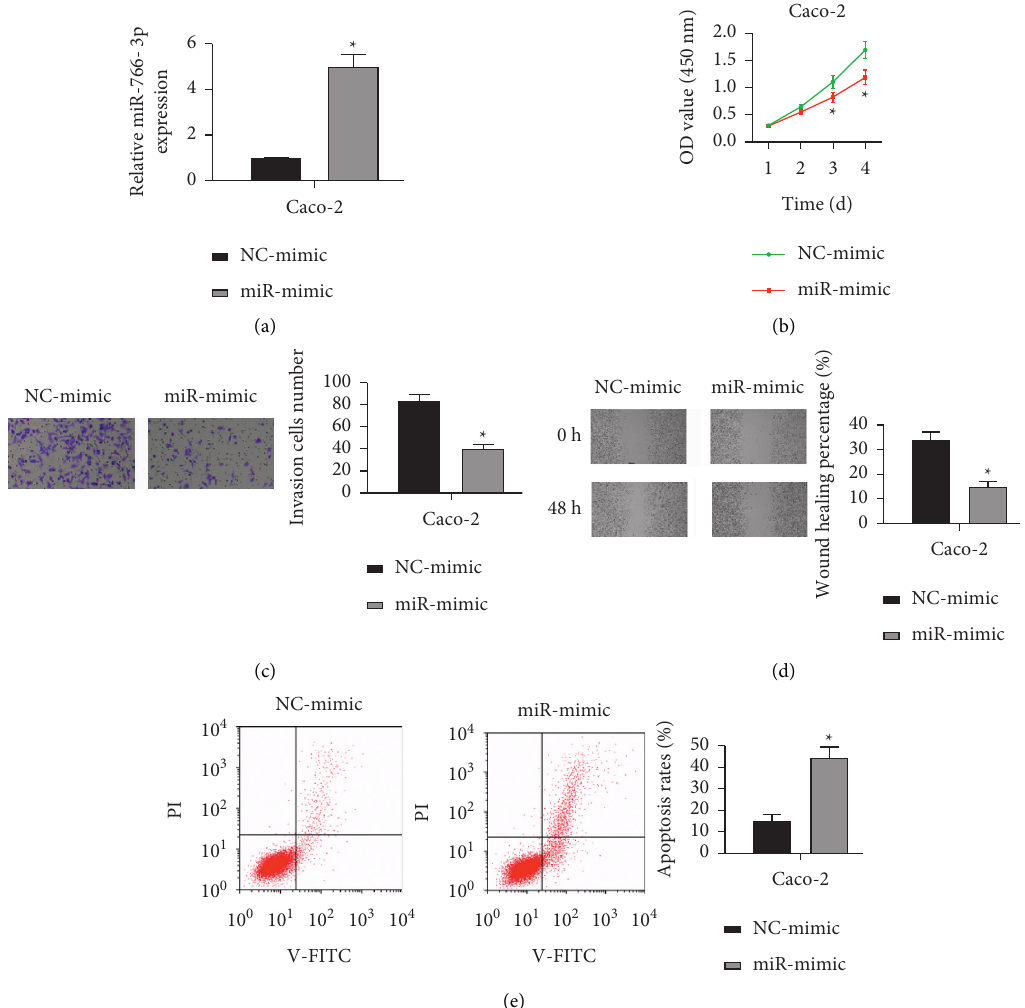
Figure 2: Forced expression of miR-766-3p affects cell malignant behaviors and apoptosis in colon cancer. (a) MiR-766-3p transfection efficiency in Caco-2 cells. (b) The proliferative ability of Caco-2 cells. (c) Invasive ability of Caco-2 cells (100 × ). (d) Migratory ability of Caco- 2 cells (40 × ). (e) Apoptotic rate of Caco-2 cells. ∗ P < 0 . 05.